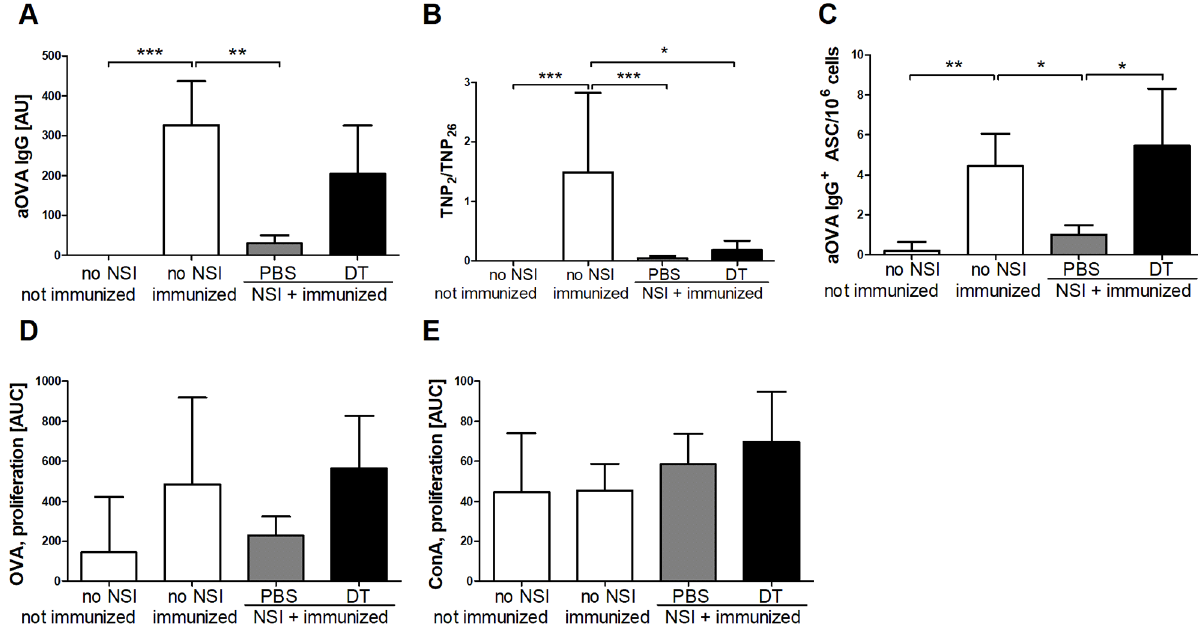
Fig 6. Treg depletion prior to immunization of NSI-treated mice. DEREG mice (n = 12) were non-specifically immunized (NSI, adapted from [29]). On days 5 and 6, the animals were given 1 μ g of diphtheria toxin intraperitoneally to deplete Tregs; control mice received the same volume of PBS (n = 12). Seven days after NSI, the animals were primed by intra-peritoneal immunization with TNP-OVA/OVA in alum. Animals without NSI and immunization (n = 6) and animals immunized with TNP-OVA/OVA without prior NSI (n = 9) served as controls. The relative concentration of anti- OVA IgG (A) and the relative antibody affinity (B) were measured as described in the caption of Fig 5. (C) Numbers of OVA-specific IgG-secreting cells in the bone marrow were determined in an ELISpot assay. (D) The proliferative response of splenocytes to restimulation with OVA was measured in a proliferation assay ex vivo .(E) The proliferative response to concanavalin A (ConA) served as control. Means and the 95% confidence interval are shown. Group differences were tested for significance with the Kruskal-Wallis test and Dunn’s multiple comparison for selected pairs. Results from two separate experiments were combined. (cid:3)(cid:3)(cid:3) P < 0.001; (cid:3)(cid:3) P < 0.01; (cid:3) P <